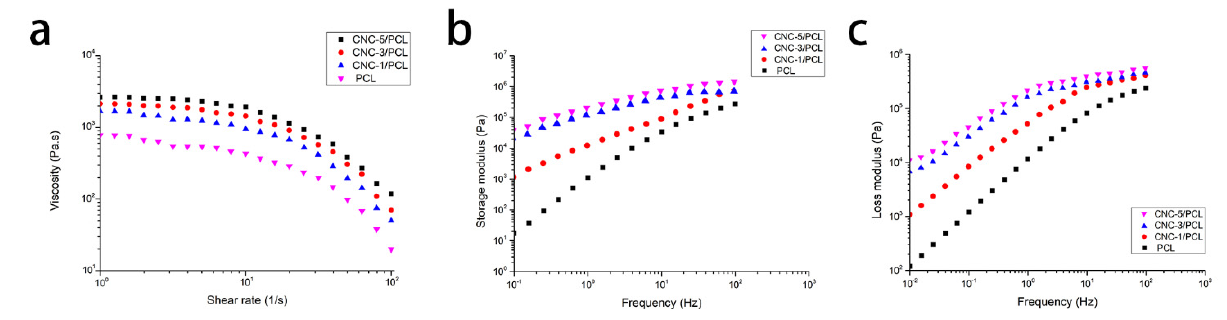
Figure 6. Variation of viscosity with shear rate ( a ), the storage modulus ( b ), and loss modulus( c ) as a function of angular frequency in pure PCL and PCL/CNC composites with different contents of CNC.